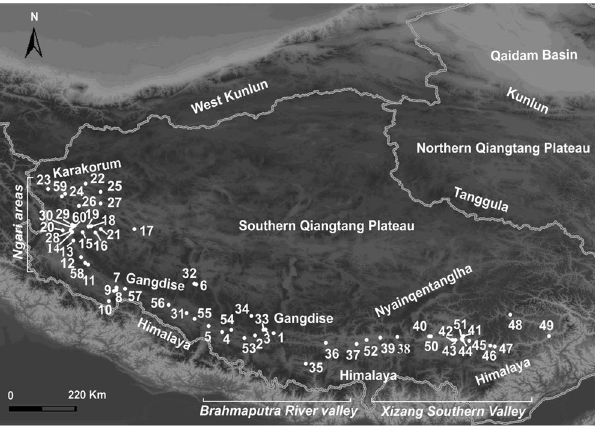
Figure 1. The Phrynocephalus theobaldi sample sites, numbered 1–60, on the Southern Tibetan Plateau, China, and surrounding region, from which the 345 specimens were obtained (map data were provided by the Scientific Data Centre of the Chinese Academy of Sciences and the final map produced by the authors using the software ArcGis